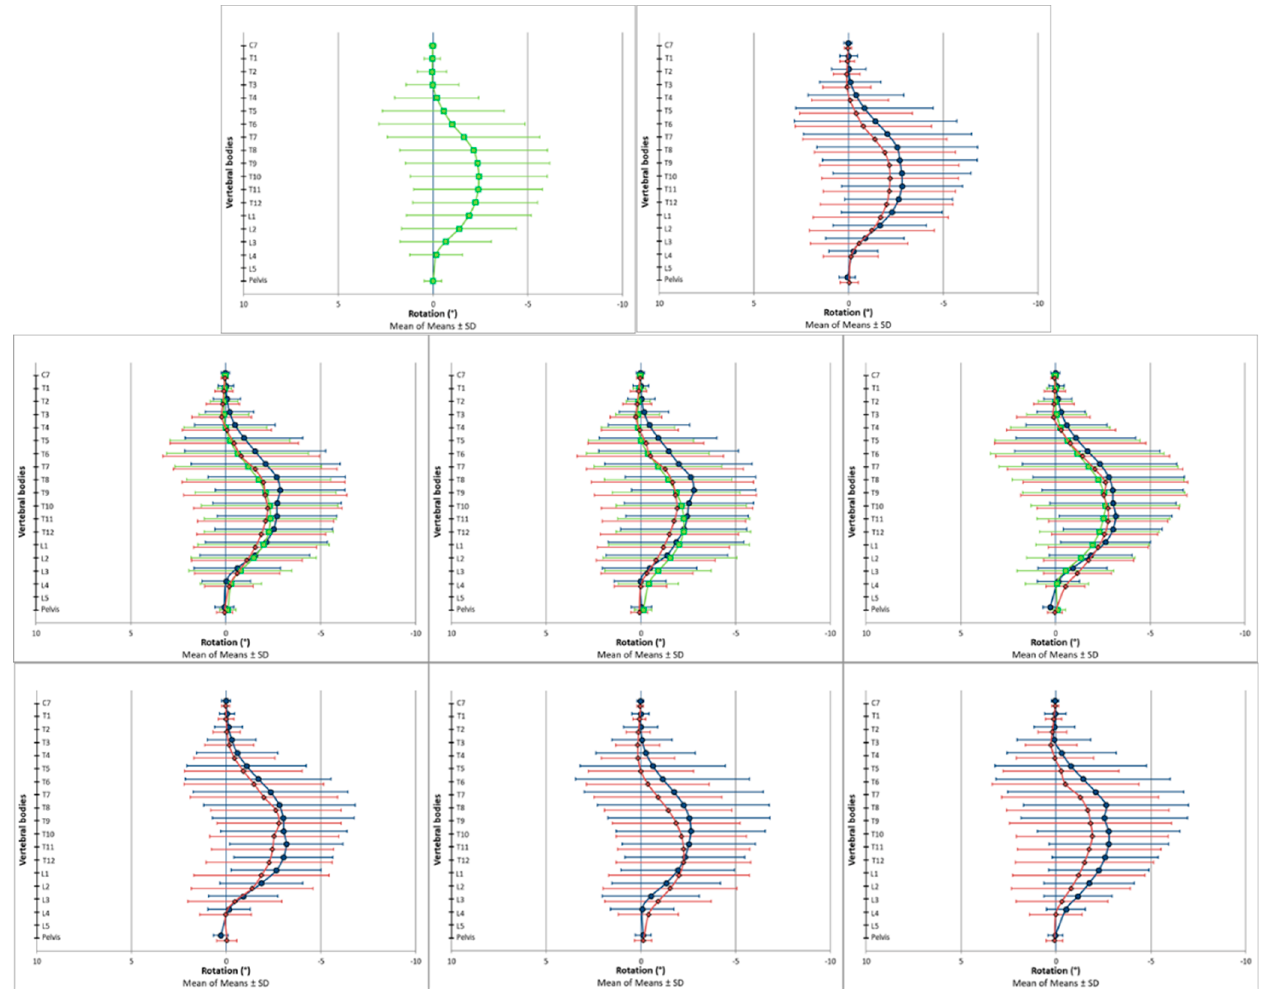
Figure 2. Vertebral body positions in the transversal plane. Positive values represent a rotation of the vertebral bodies to the left (counterclockwise), and negative values represent a rotation of the vertebral bodies to the right (clockwise). The scale of the x -axis is turned to enhance the intuitive visual interpretability of the results: ( Upper row ) (left picture: all participants ( (cid:110) , green); right picture: all female ( (cid:117) , red) and all male ( • , blue) participants). ( Middle row ) (left picture: all participants of the respective age cohorts: young ( • , blue), middle ( (cid:110) , green) and old ( (cid:117) , red); middle picture: all female participants of the respective age cohorts: young ( • , blue), middle ( (cid:110) , green) and old ( (cid:117) , red); right picture: all male participants of the respective age cohorts: young ( • , blue), middle ( (cid:110) , green) and old ( (cid:117) , red)). ( Lower row ) (left picture: all young female ( (cid:117) , red) and all young male ( • , blue) participants; middle picture: all middle-aged female ( (cid:117) , red) and all middle-aged male ( • , blue) participants; right picture: all old female ( (cid:117) , red) and all old male ( • , blue)